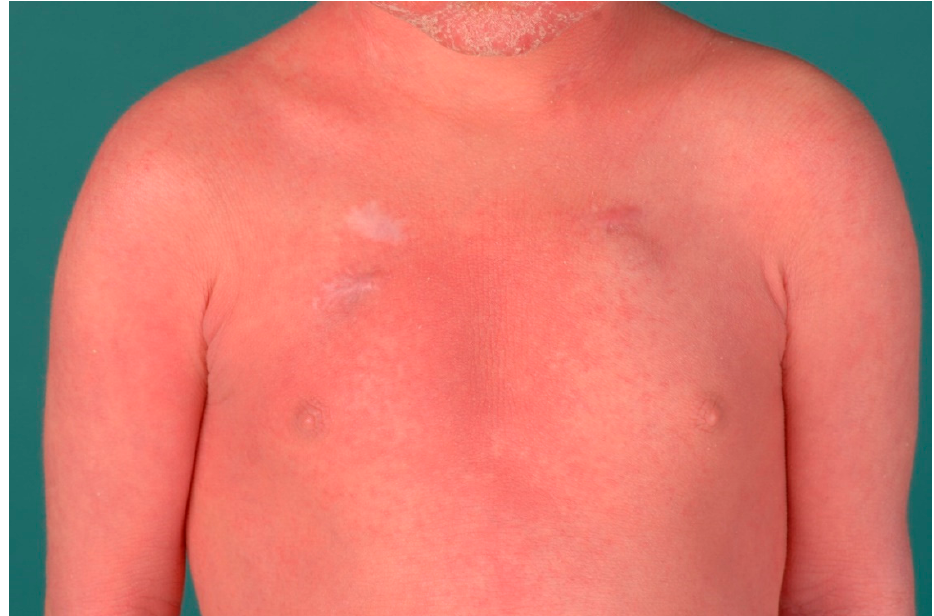
Figure 9. Netherton syndrome. Erythema and scaling of the trunk and face.